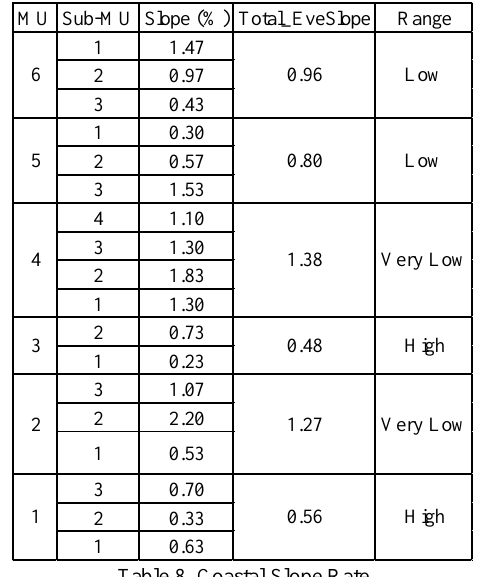
Table 8. Coastal Slope Rate Data for Mean Tidal Range is -0.025 meter in rank of very high rank for each MU. Relative sea level rise is 0.291492 cm/year for Kukup station with moderate ranking. Figure 17 below show CVI map that showing the risk area where the very high rankings are the most risk to get